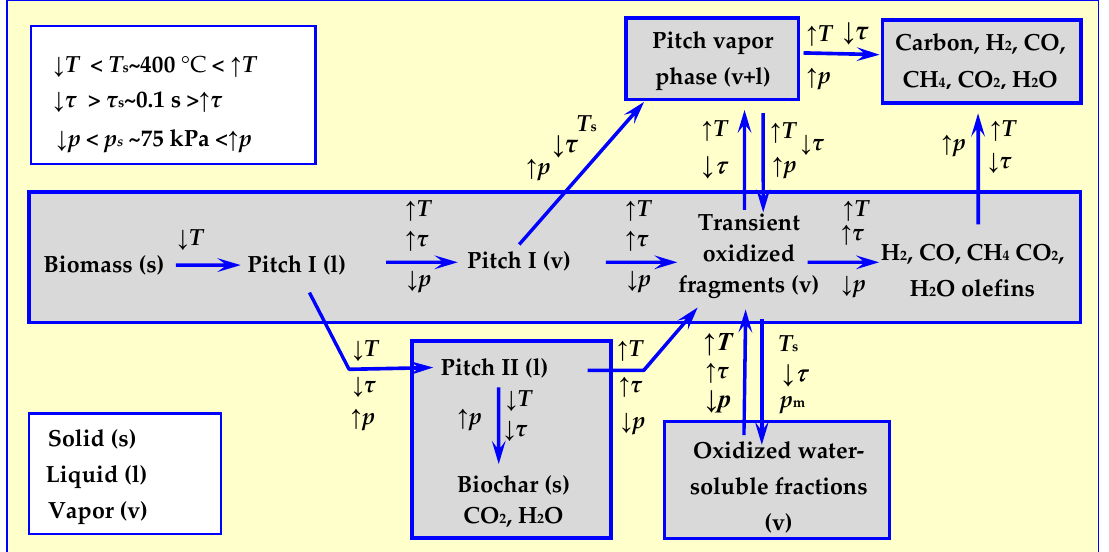
Figure 4. A comprehensive model of thermal biomass decomposition taking into account the influence of temperature, velocity and pressure of pyrolysis [30] based on [17].